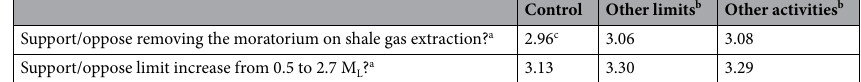
Table 2. Wave 2 survey: policy support across information conditions. a Six-point bipolar scale, with don’t know (DK = 16% for removing the moratorium, 20% for increasing the limit) (1 = Strongly oppose, 2 = Moderately oppose, 3 = Slightly oppose, 4 = Slightly support, 5 = Moderately support, 6 = Strongly support). b See methods for text of information provision on ‘other limits’ and ‘other activities’. c Following ANOVA tests, Tukey post-hoc tests for differences between means of the two policy-relevant attitudes, across the three treatment conditions, revealed no significant